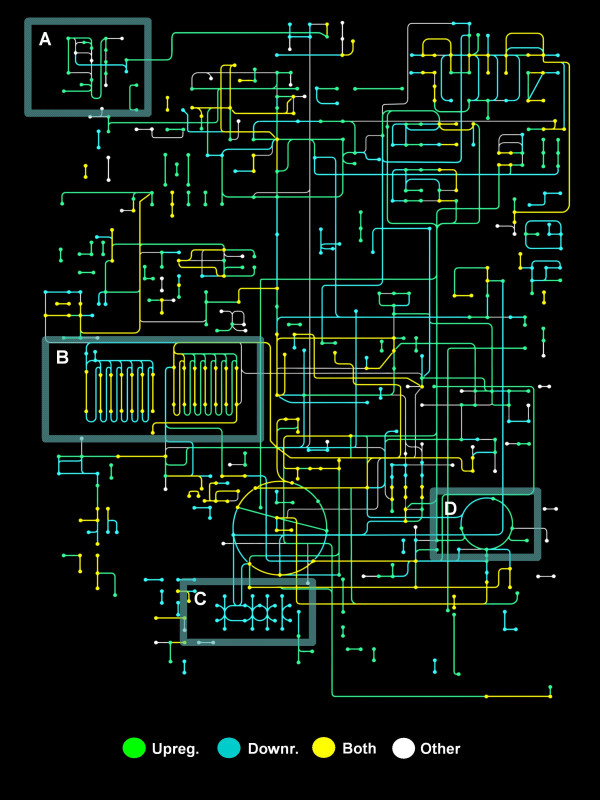
Metabolic Atlas of Physarum polycephalum. All P. polycephalum cDNAs (Refs [5,6] and our results) were sent for KEGG Ortholog [19] (KO) prediction using the KAAS server [20]. The output list of orthologs was used to plot this atlas with the KEGG mapping tool [21]. Nodes represent metabolites and edges (lines) correspond to enzymatic reactions. Colors are assigned to either down- (light blue) or upregulated (green) transcripts. Transcripts with equivalent relative frequencies in both novel cDNA libraries (relL/relD = 1) are also depicted (yellow); white represent those cDNAs with no expression data. After photoinduction, most enzymes from the N-glycan biosynthesis (A) and the urea cycle (D) pathways are upregulated. In contrast, cDNAs mapped to the oxidative phosphorylation (C) had higher relative frequencies in competent plasmodia, whereas a change from fatty acid synthesis to degradation is seen after photoinduction (B).